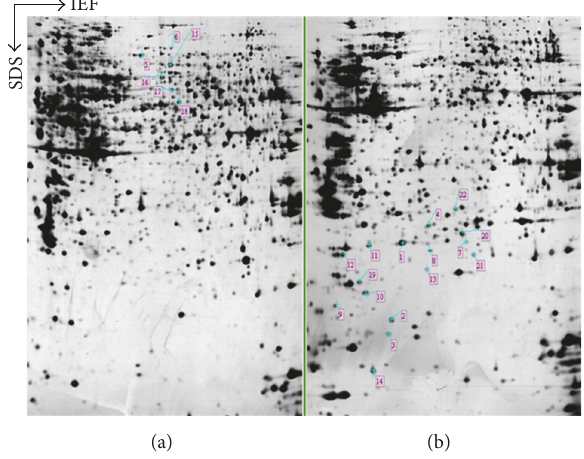
Figure 2: Two-dimensional electrophoresis (2DE) map of HUVEC. (a) Normal HUVEC; (b) HUVEC treated with 50 𝜇 mol/L elaidic acid.Firstdimension:IPG3–10,17 cm,NL;seconddimension:12.5% SDS-PAGE gels. Among the 22 different expression proteins, 20 spots were identified by peptide mass fingerprinting and MS/MS analysis. Corresponding identifications are reported in Table